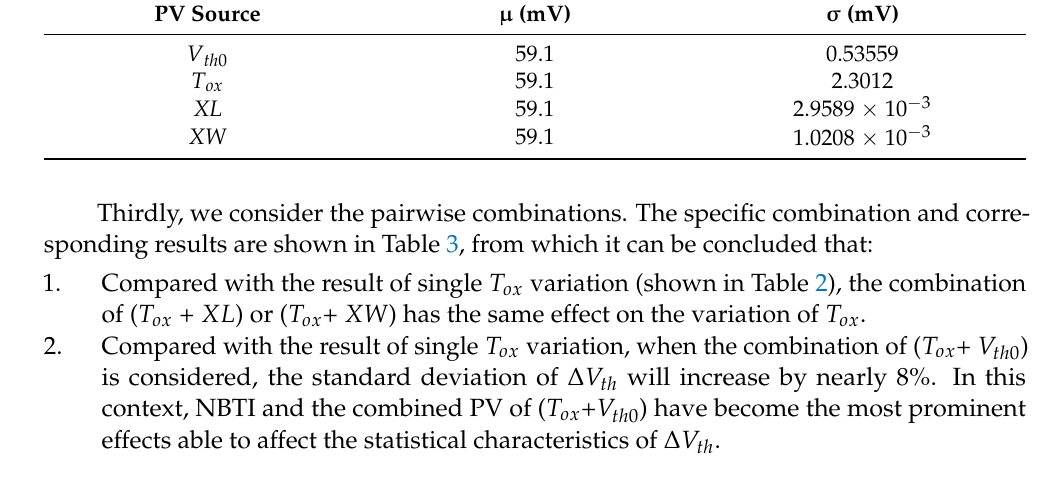
Table 3. The statistical characteristics of ∆ V th by pairwise combined PV